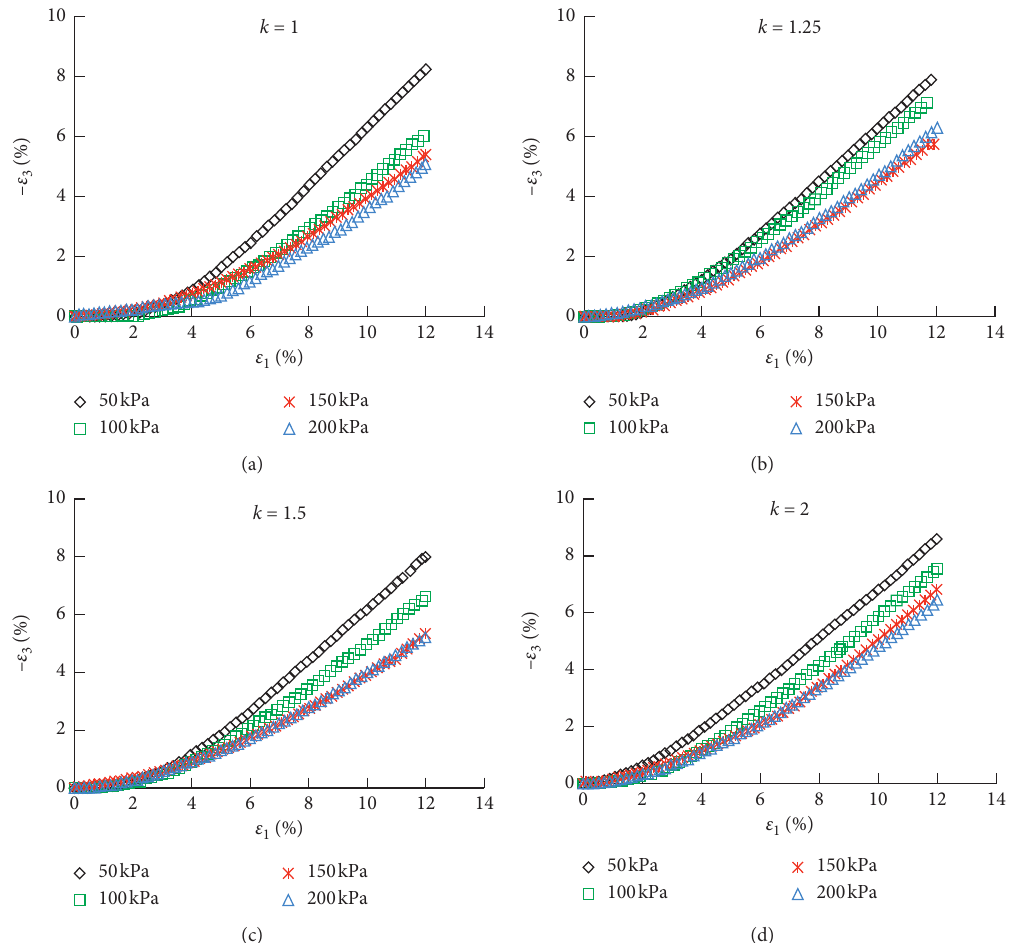
Figure 5: Lateral strain-vertical strain curves of intact loess at different k